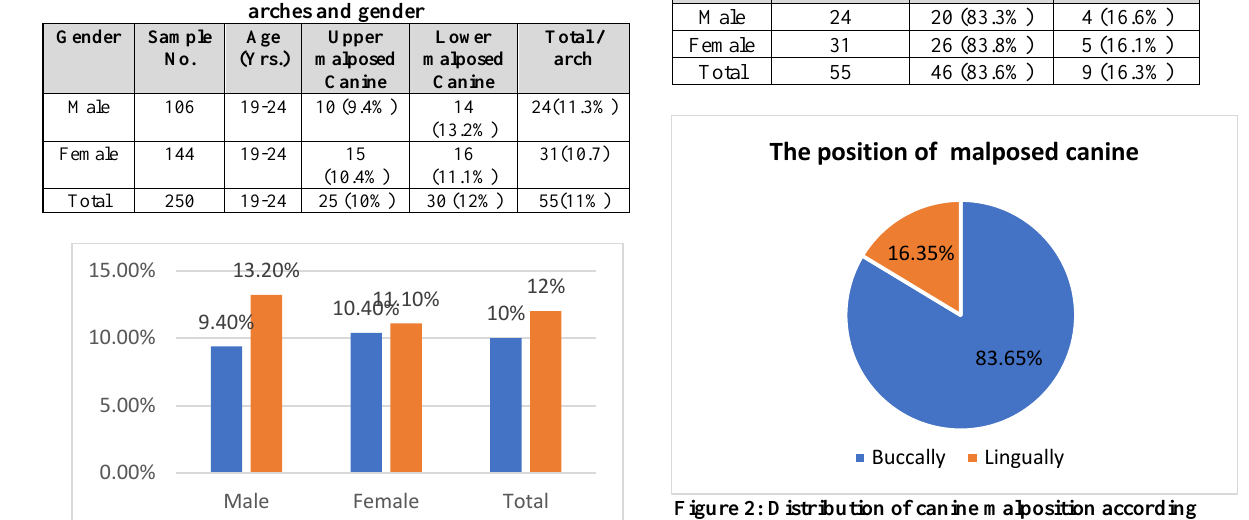
Table 1: Distribution of malposed canines in both